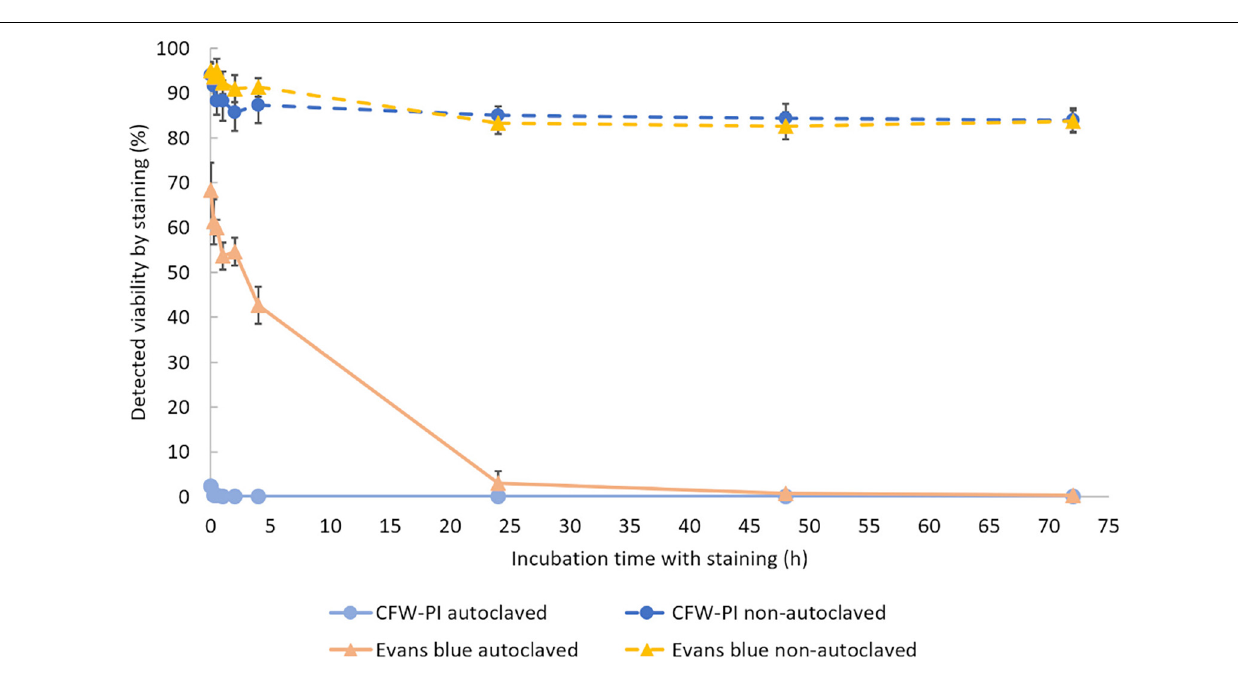
FIGURE 4 | Viability of autoclaved and non-autoclaved spores of Plasmodiophora brassicae determined by different staining methods during 72 h of incubation. Error bars indicate standard deviations ( n =